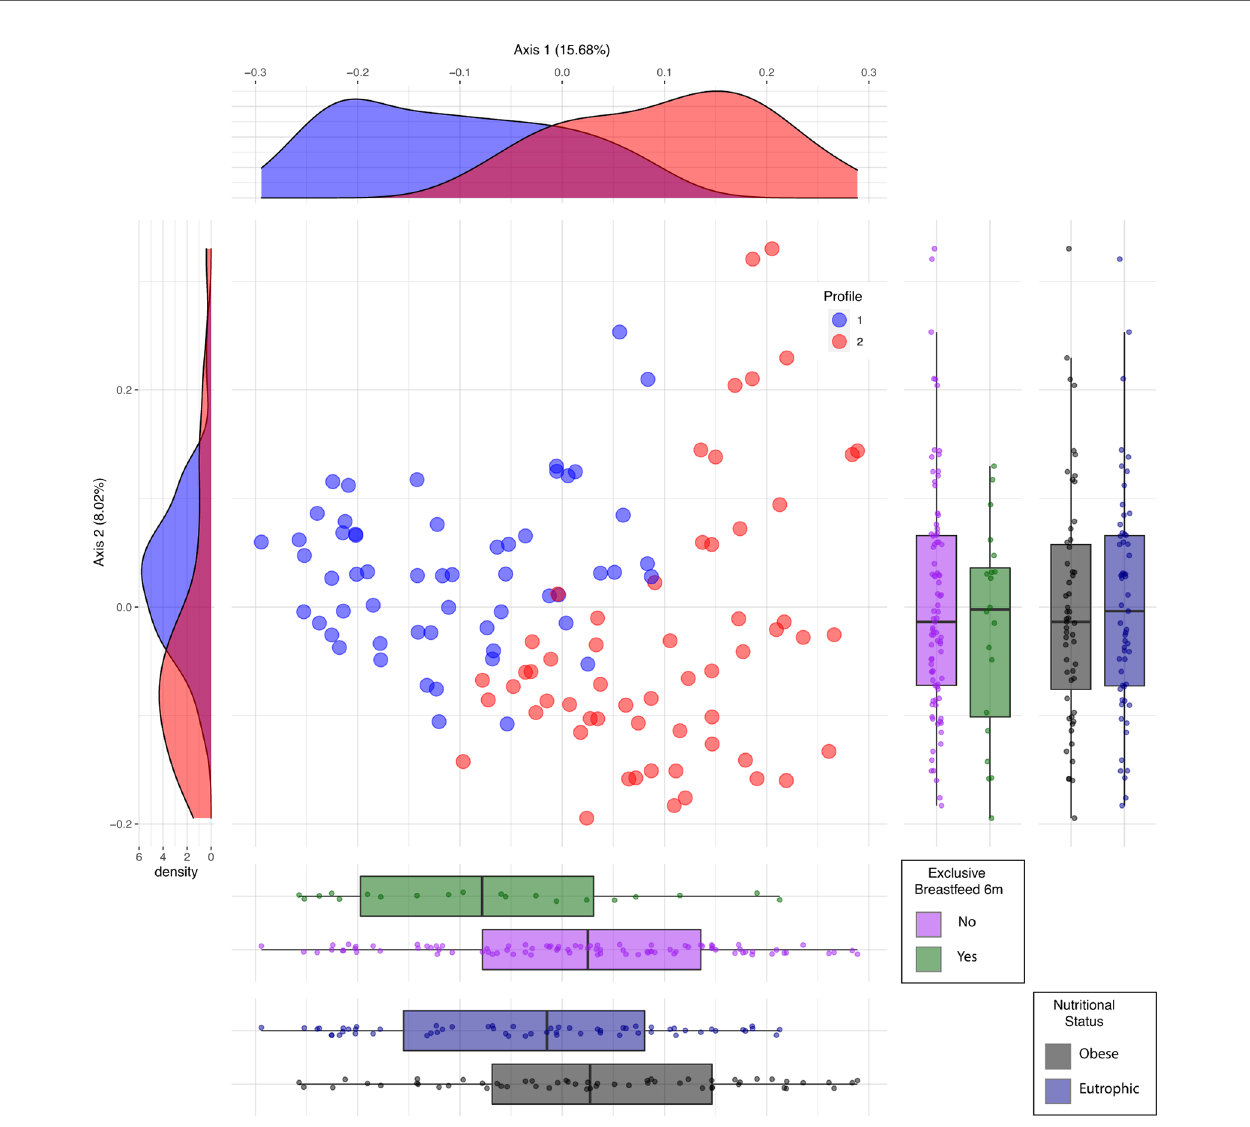
FIGURE 2 | Pro fi les driven by Blautia (#1) and Prevotella (#2) identi fi ed by principal coordinates analysis (PCoA). #1 in blue is driven by Blautia ; #2 in red is driven by Prevotella . Vertical boxplots represent the distribution of participants according to categories of breastfeeding and nutritional status (p < 0.05). Horizontal boxplots show the distribution of participants into pro fi les strati fi ed by these